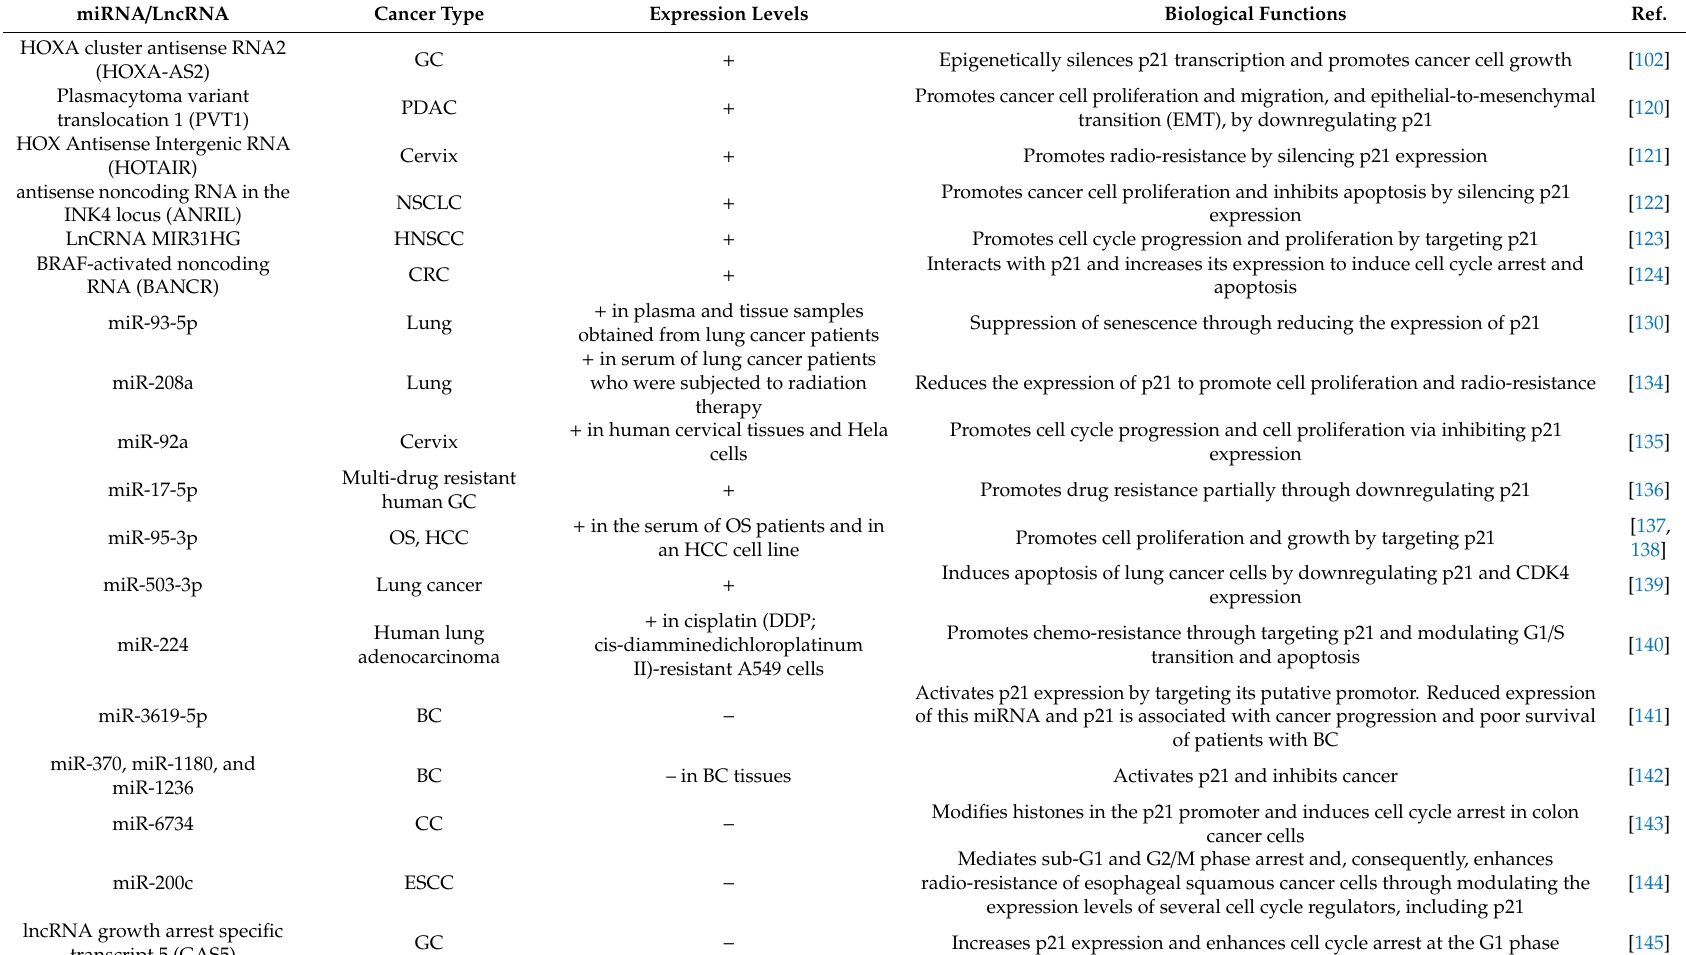
Table 3. miRNAs and lncRNAs involved in the deregulation of p21 in